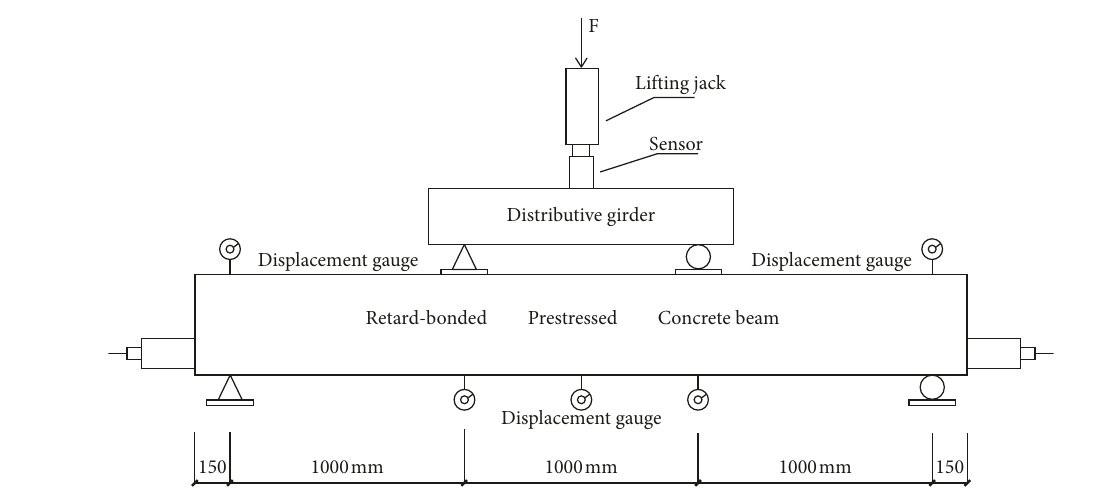
Figure 5: Loading devices and monitoring instruments.